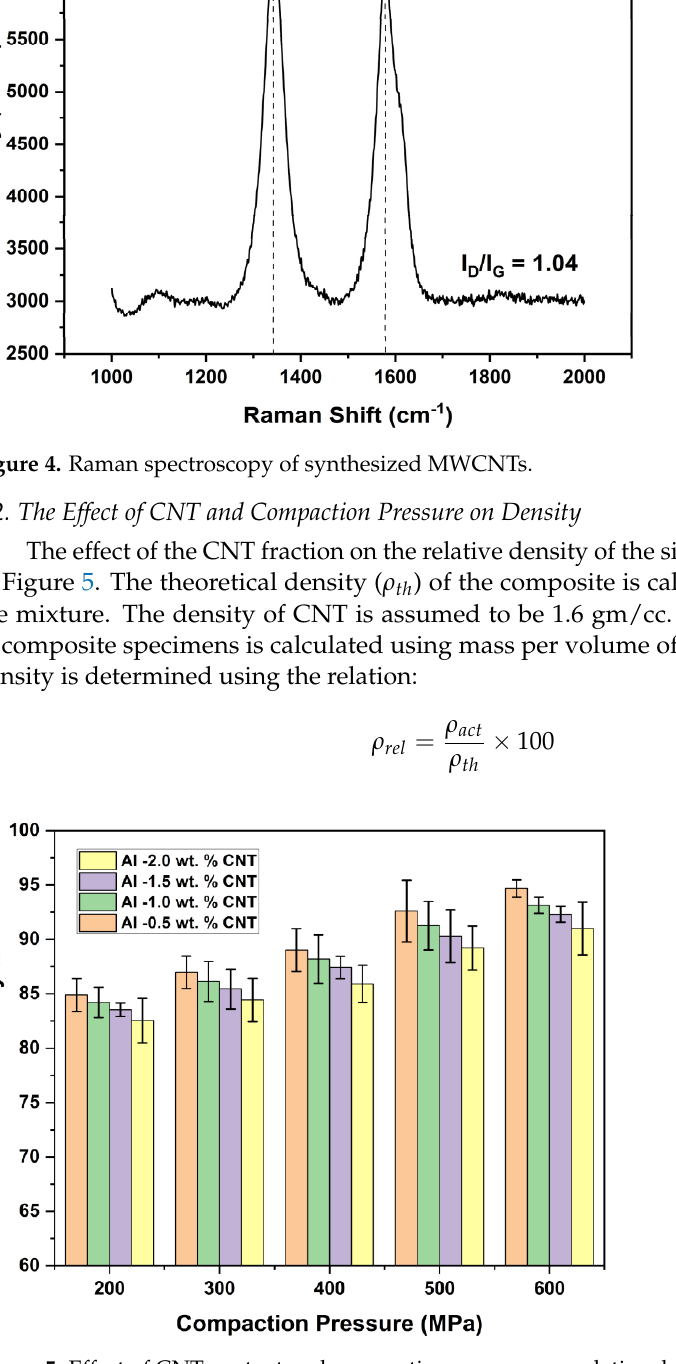
Figure 5. Effect of CNT content and compaction pressure on relative density of sintered compacts.